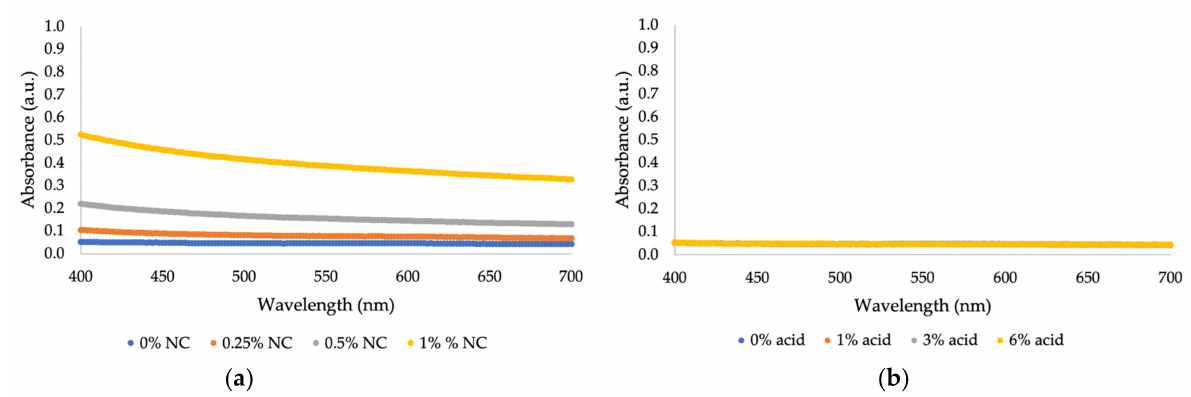
Figure A1. The absorbance of ( a ) NC and ( b ) sulfuric acid in 400–700